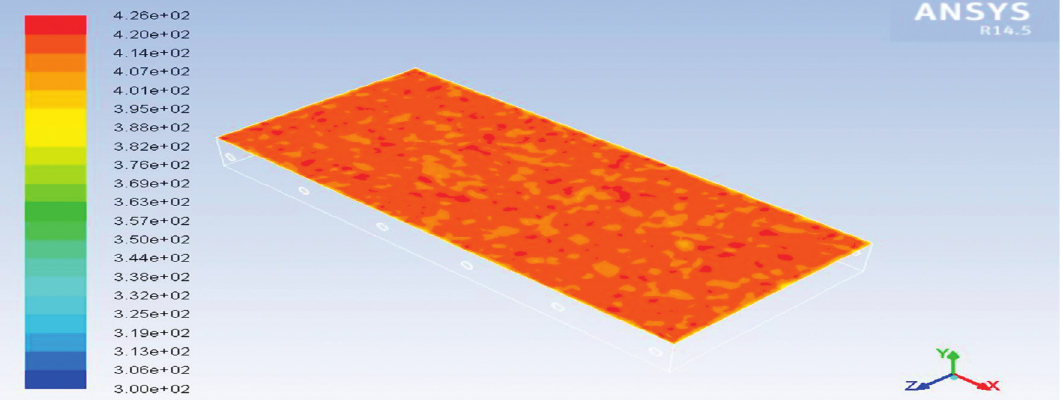
Figure 16: Contour presented the evening temperature at mid of the solar